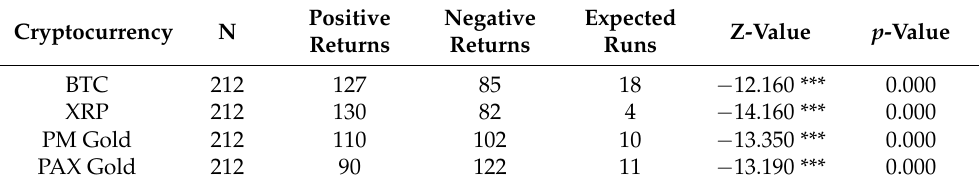
Table 2. Unit root test.